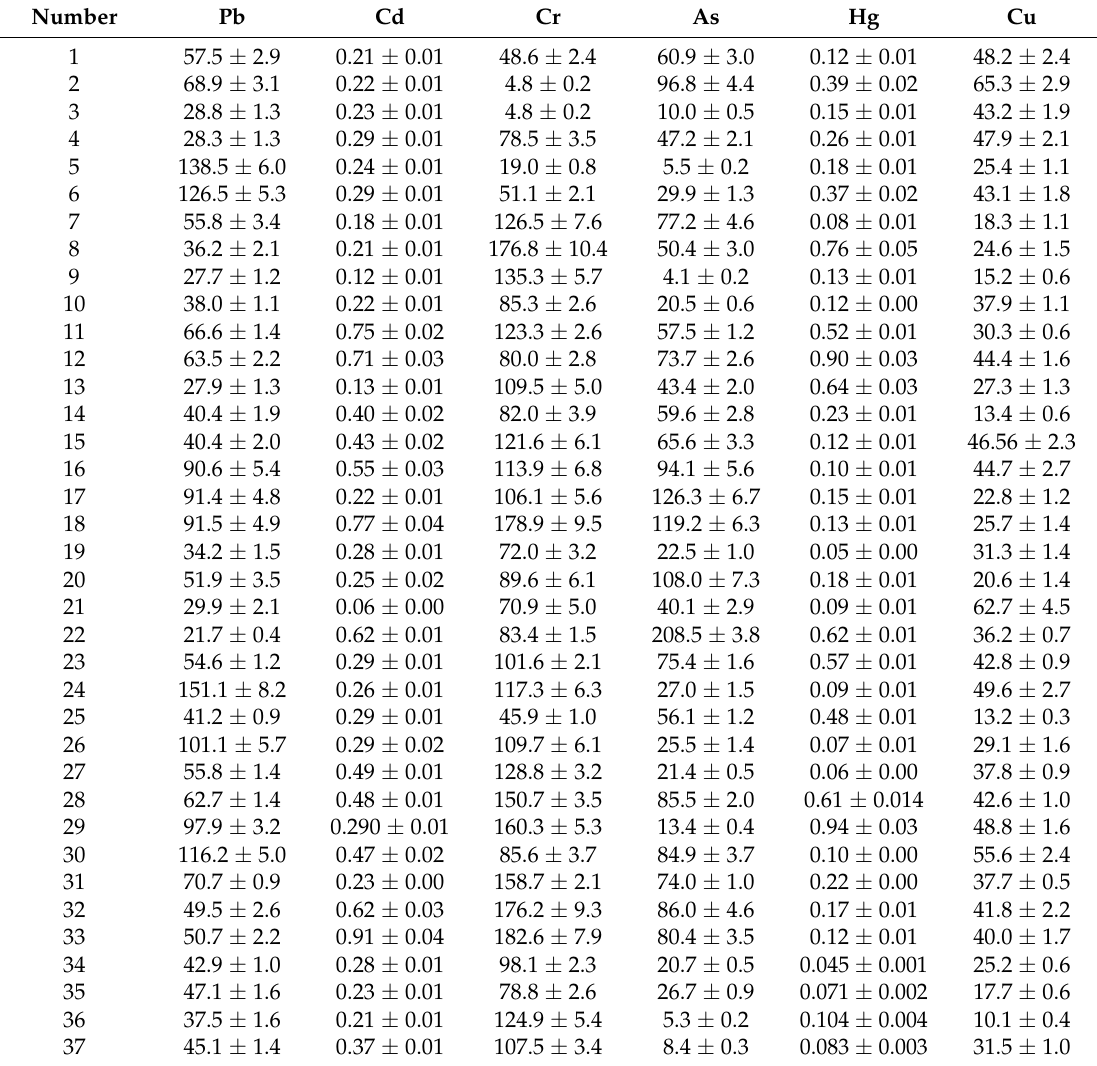
Table 4. Heavy metal content in soil samples (Mean ± SD, mg · kg − 1